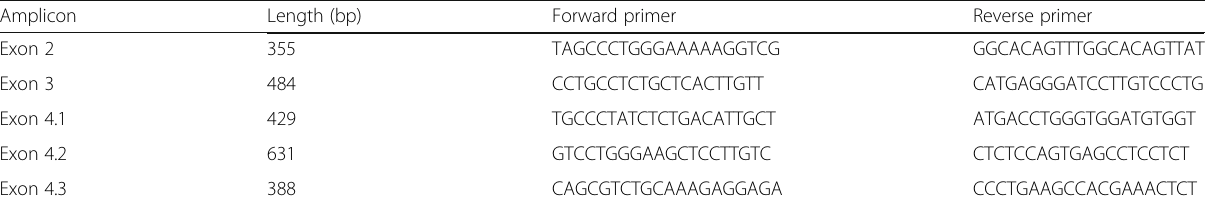
Table 1 Primers used in MECP2 amplification